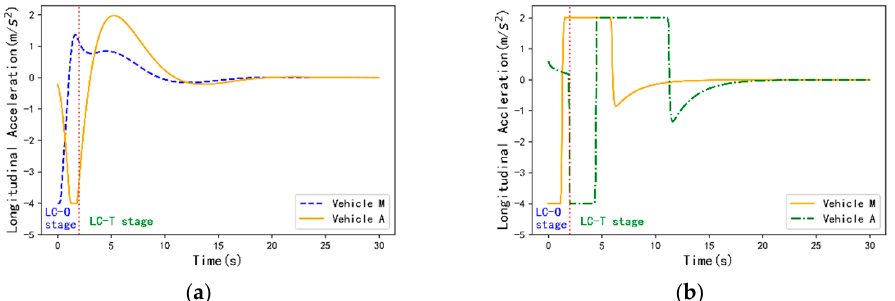
Figure 14. The longitudinal accelerations of vehicles M and A of the two control strategies in scenario 2. ( a ) The proposed CLC control strategy, ( b ) CACC_Sine control strategy.